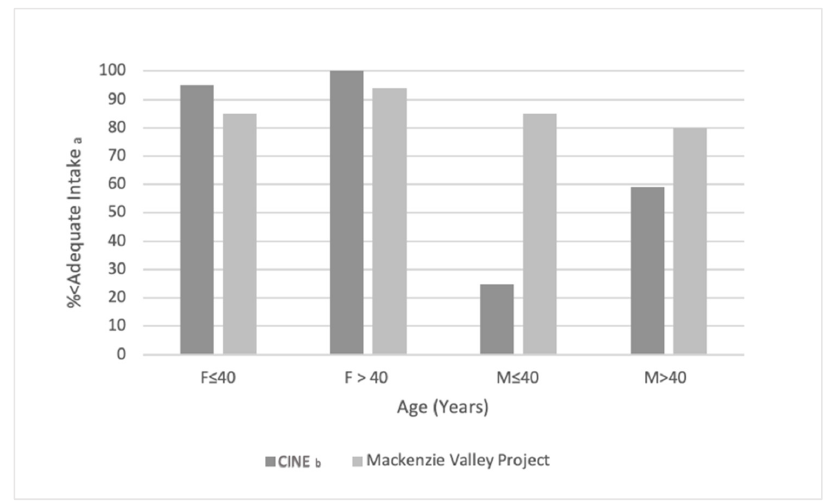
Figure 3. Temporal comparison between 1994 (CINE Study) and 2016–2018 (Mackenzie Valley Project) for Vitamin D intake less than the adequate intake (AI) in Dene/Métis adults from the NWT. a For Vitamin D, the AI was assumed at 5 mg/day for F and M ≤ 40 and 10 mg/day for F and M > 40. b From “Vitamins A, D, and E in Canadian Arctic traditional food and adult diets” [54]. F = female; M = male